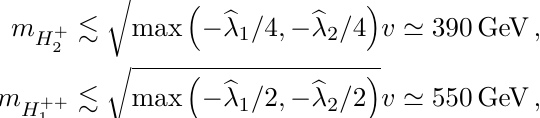
Figure 2 . Left: scatter plots of ∆ m 23 vs. m ( h 0 (in orange, purple, cyan and turquoise, respectively). Right: scatter plot of m u ≤ 8